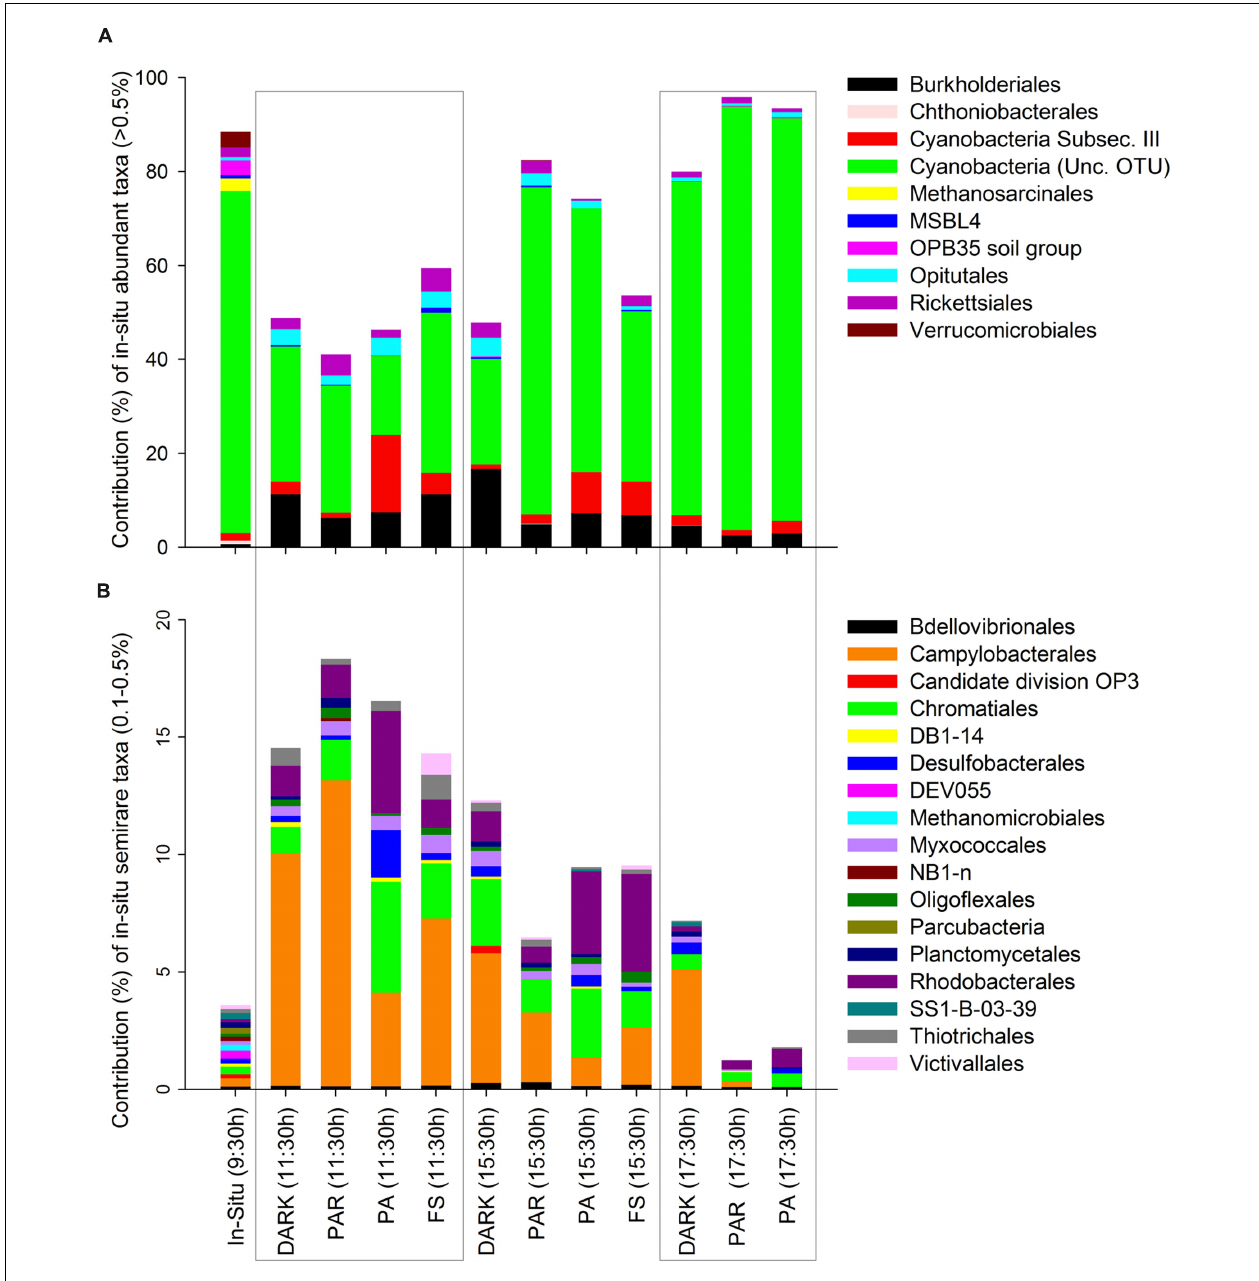
( Figure 4A : < 0.1% of contribution to the pyrolibrary) or